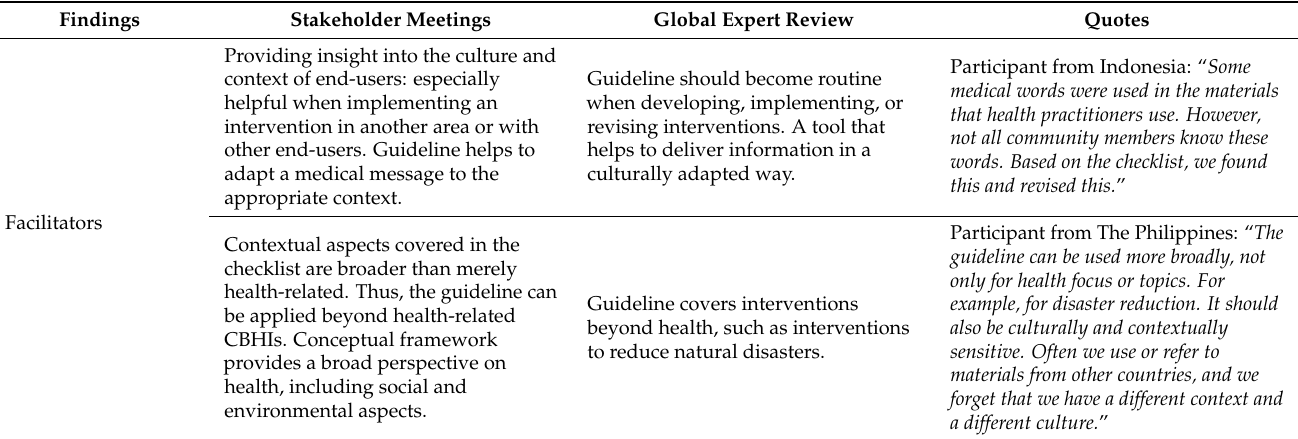
Table A2. Findings from stakeholder meetings and expert review meetings regarding facilitators and barriers of the guideline, and revisions made based on these